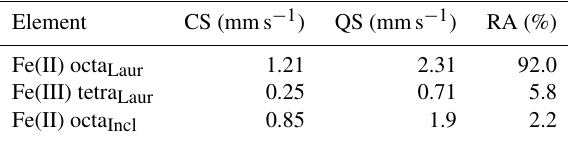
Table 4. Parameters from fitting of the Mössbauer spectrum.